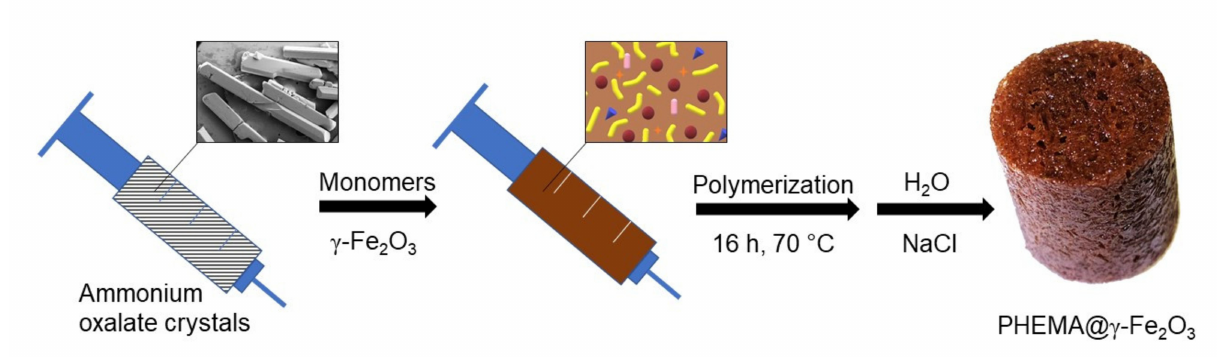
Figure 1. Scheme of preparation of a magnetic hydrogel